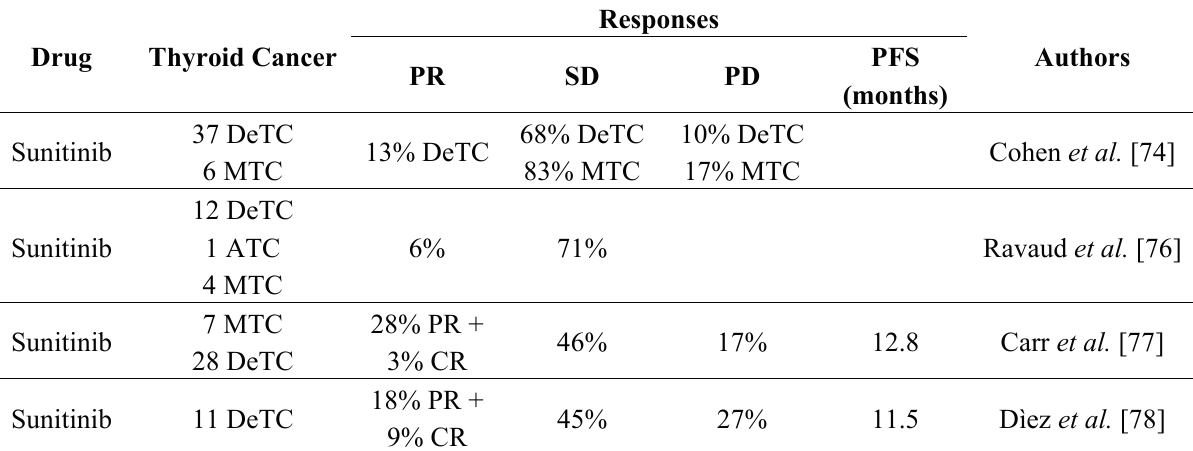
Table 2. Clinical trials of Sunitinib in patients with thyroid